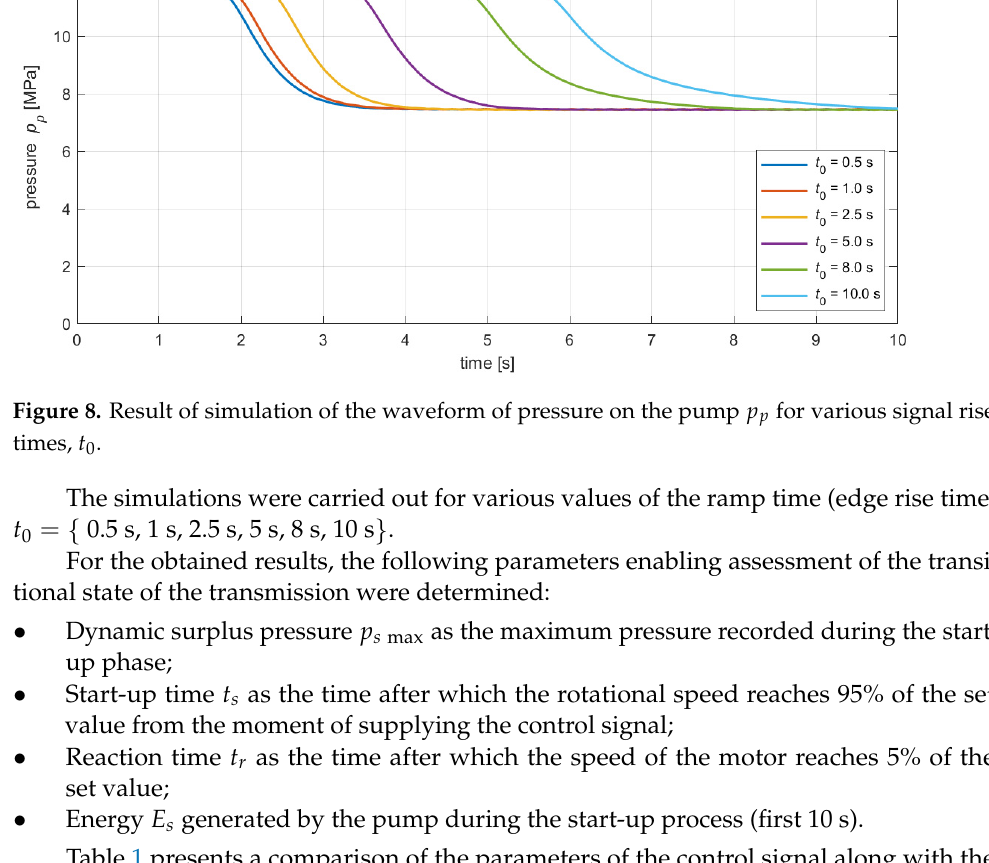
Figure 7. Result of simulation of the waveform of rotational speed 𝑛 (cid:3046) for various signal rise times, 𝑡 (cid:2868) .